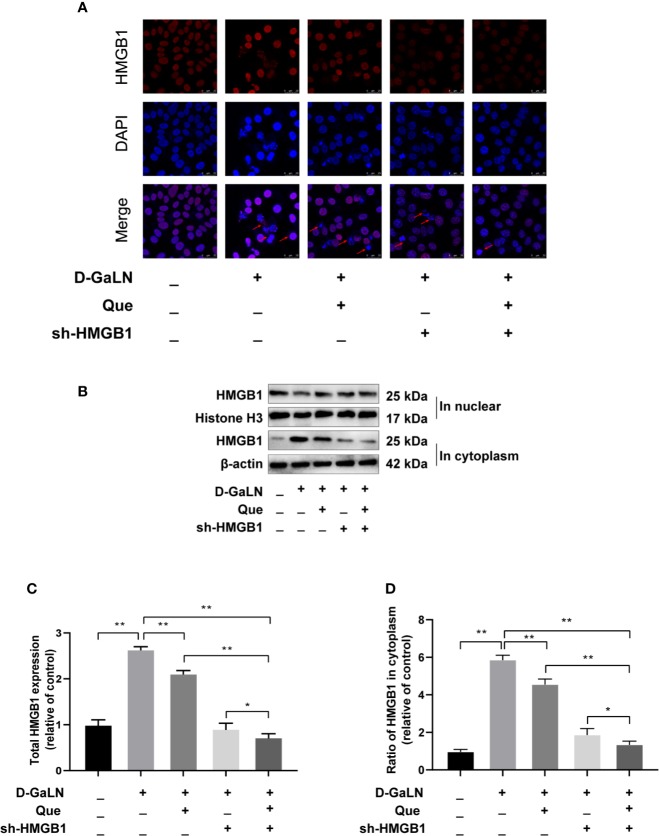
Effect of Que on d-GaLN-induced HMGB1 expression. (A) Immunofluorescence staining of HMGB1 expression under different treatment conditions. Scale bar: 25 μm; Arrows indicate the HMGB1. (B) Representative immunoblots for the HMGB1 in the nucleus, Histone H3, HMGB1 in the cytoplasm, and β-actin proteins. (C, D) Total HMGB1 and ratio of HMGB1 in cytoplasm under different exposure conditions by Western blot assay. The data on HMGB1 expression in the cytoplasm were normalized by related β-actin proteins, HMGB1 in the nucleus were normalized by related Histone H3 proteins (fold change of control). Data are presented as the mean ± SD of three technical replicates(*p < 0.05, **p < 0.01).